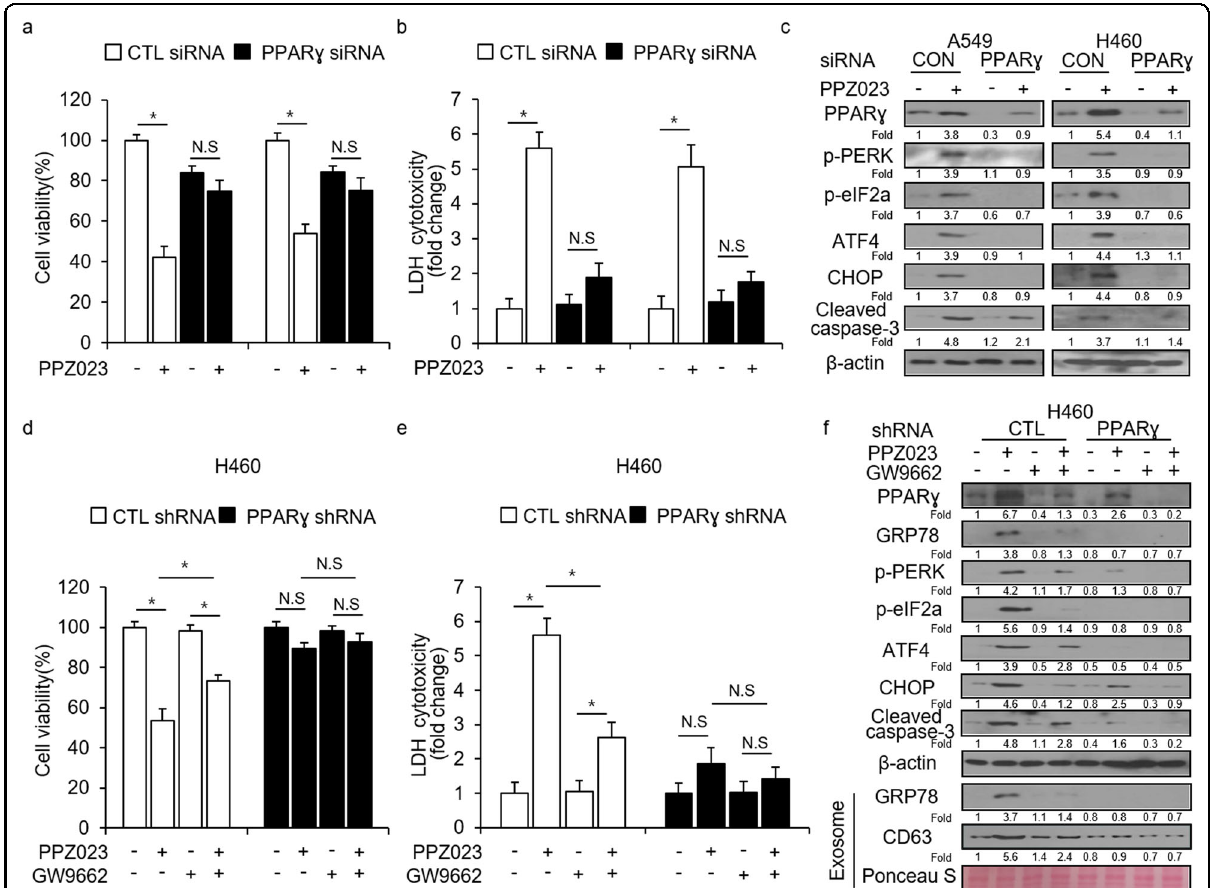
Fig. 6 Suppression of PPAR ɣ inhibits PPZ023-induced cell death in NSCLC cells. a – c A549 and H460 cells were transfected with PPAR ɣ siRNAs and treated with PPZ023 (25 μΜ , 24 h). Next, cell viability and LDH assays were performed along with western blot analyses of PPAR ɣ , p-PERK, p-eIF2 ɑ , ATF4, CHOP, and cleaved caspase-3; * p < 0.05. β -Actin was used as the protein loading control. d – f Stable PPAR ɣ -knockdown H460 cell lines were established after H460 cells were transfected with a PPAR ɣ shRNA. These cells were treated with PPZ023 (25 μΜ , 24 h), GW9662 (20 μ M, 24 h), or PPZ023/GW9662, and cell viability and LDH assays were performed along with western blot analyses of PPAR ɣ , GRP78, p-PERK, p-eIF2 ɑ , ATF4, CHOP, and cleaved caspase-3; * p < 0.05. β -Actin was used as the protein loading control, and Ponceau S stain was used as the exosome loading